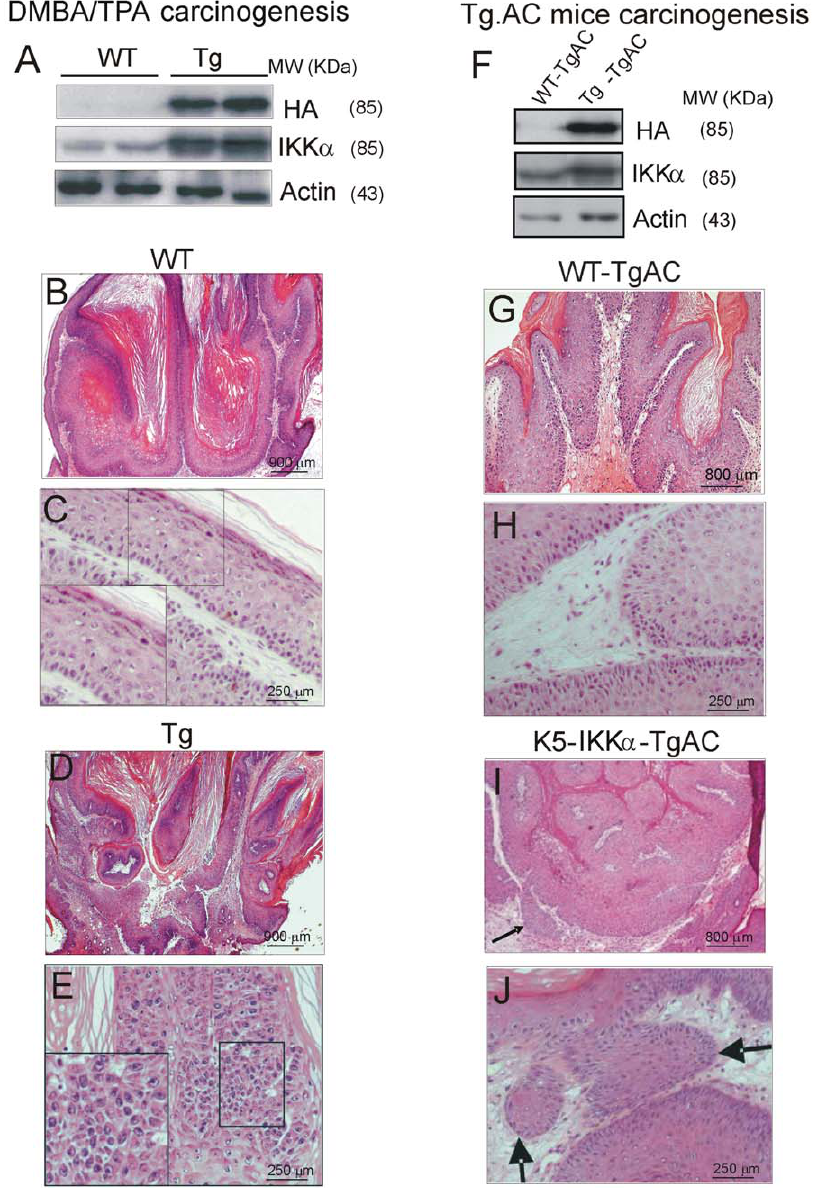
Figure 4. Tumors from K5-IKK a transgenic mice show increased malignancy. ( A, E ) Tumors developed in WT and Tg mice in the DMBA/TPA skin carcinogenesis assays. ( A ) Western blot showing the expression of the transgene in the tumors. Total protein extratcs from two different tumors developed in transgenic mice of the line L1 and proteins from two different control mice were loaded. ( B – E ) Histology of tumors arising in mice subjected to the DMBA/TPA approach. Note the epithelial atypia areas in Tg tumors (inbox in E ) versus the well conserved tissue architecture in WT tumors ( C ). ( F – J ) Tumorigenesis in Tg.AC mice. (F) Western blot showing the expression of the transgene in the tumors. Total protein extratcs were loaded. ( G, H ) Development of benign tumors in WT-TgAC mice versus invasive tumors K5-IKK a -TgAC mice ( I, J ) . ( J ) High magnification showing the rupture of the basement membrane and invasion of tumor epidermal cells into the stroma of transgenic tumors. Arrows in ( I, J ): focal invasion areas.